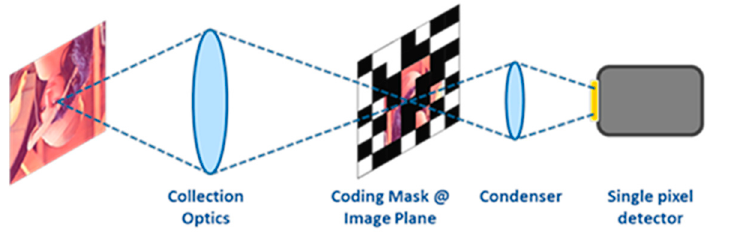
Figure 1. CS approach: working principle of the single pixel